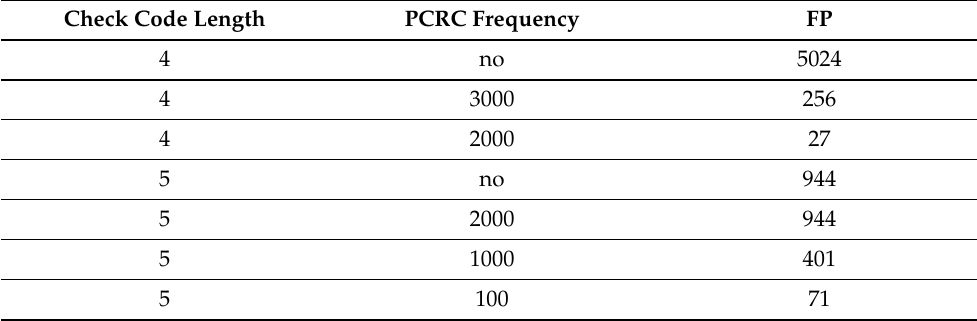
Table 1. Number of FP for five antennas when varying the length and frequency of check